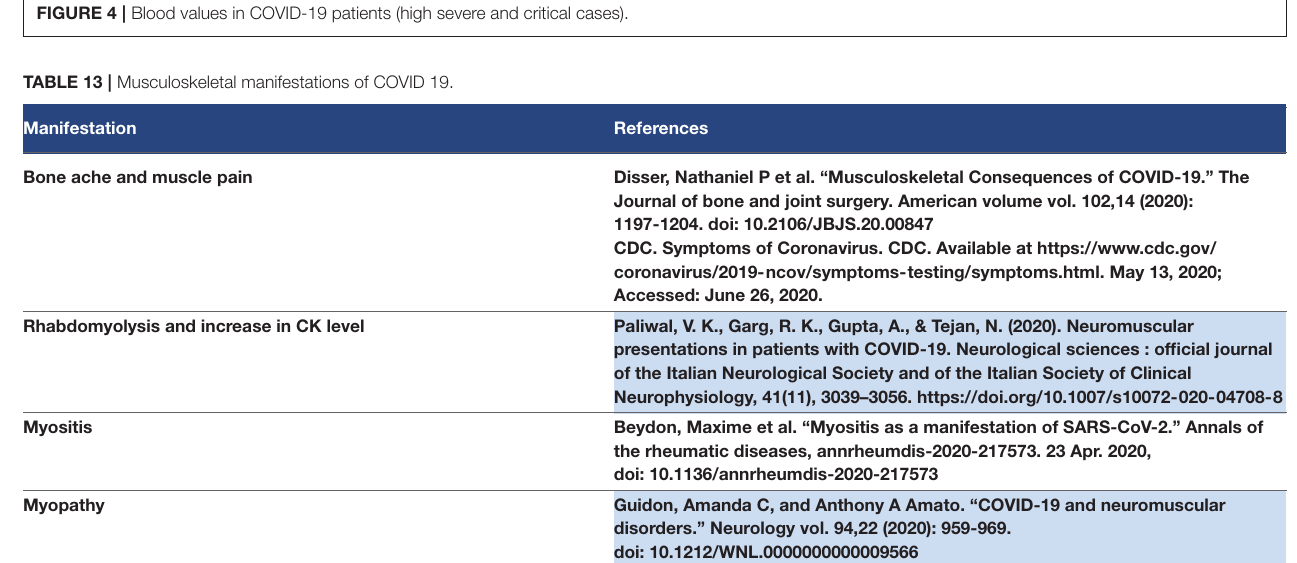
FIGURE 4 | Blood values in COVID-19 patients (high severe and critical cases).